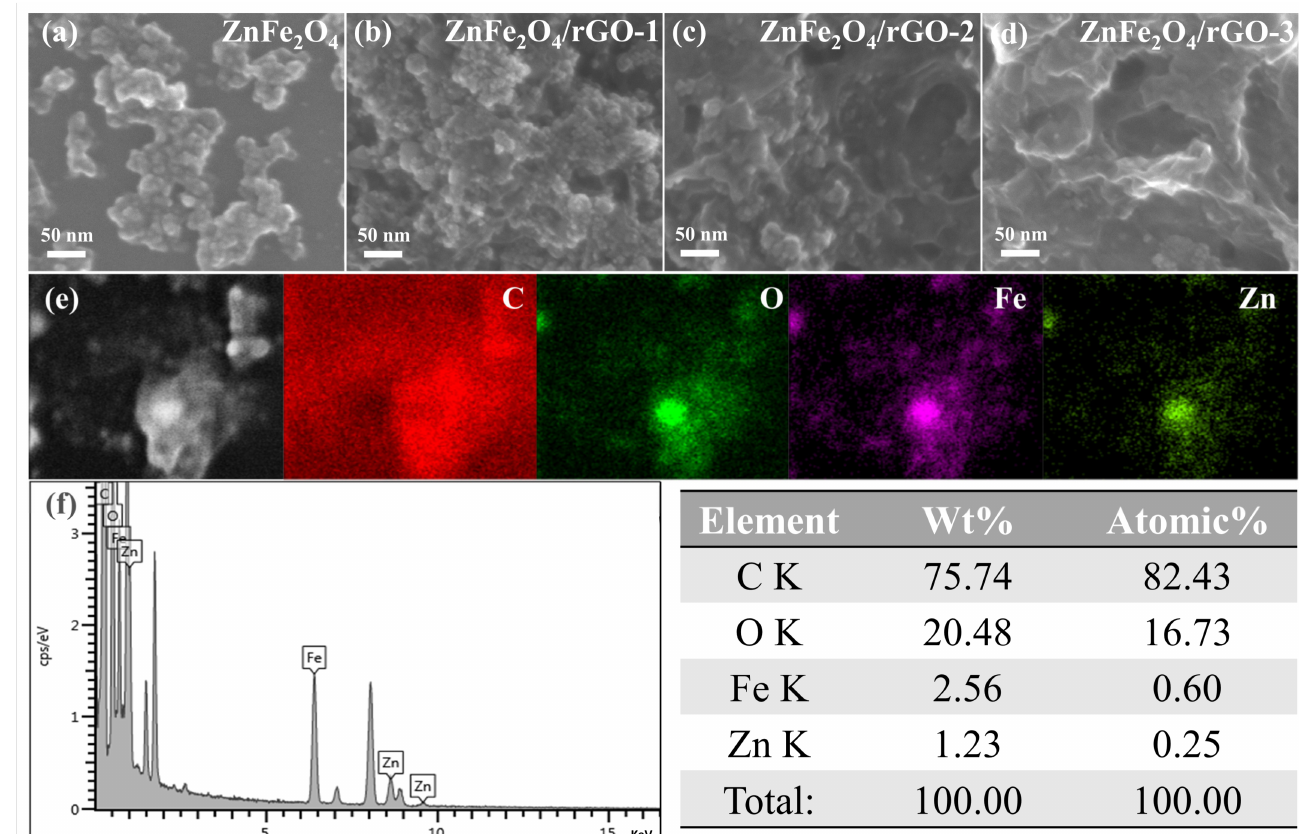
the element distribution of C, O, Fe, and Zn can be observed. Figure 4f shows the elemental contents of ZnFe 2 O 4 /rGO − 2 at the selected area.